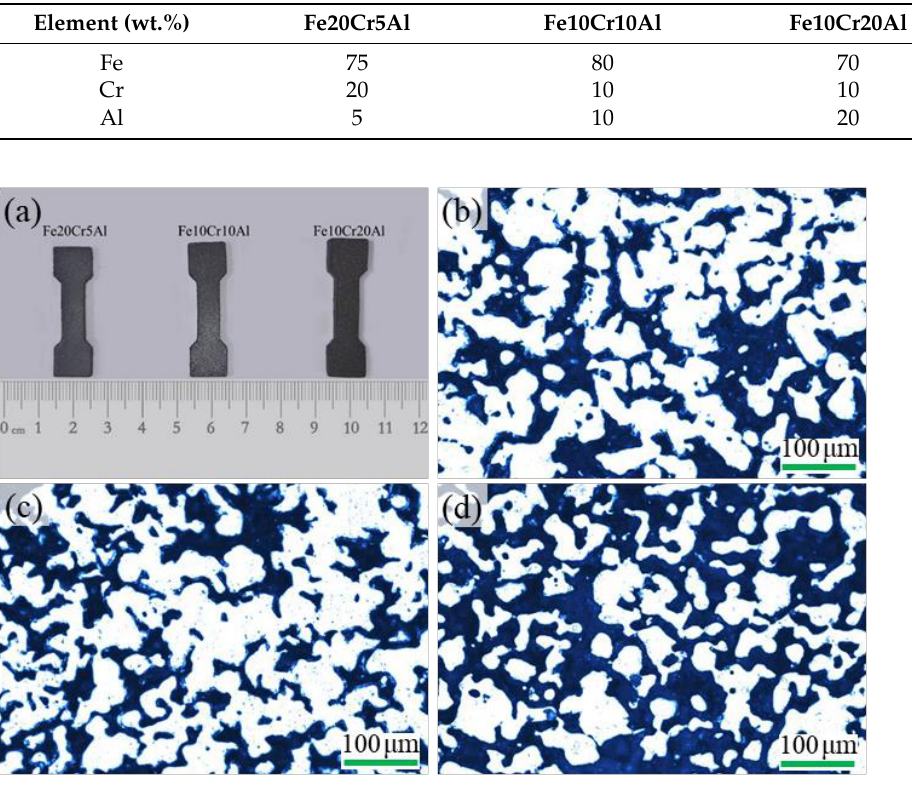
Figure 1. The bone-shaped tensile test samples ( a ) and the sectional view images of porous ( b ) Fe20Cr5Al, ( c ) Fe10Cr10Al and ( d ) Fe10Cr20Al. ( b ) Fe20Cr5Al, ( c ) Fe10Cr10Al and ( d )